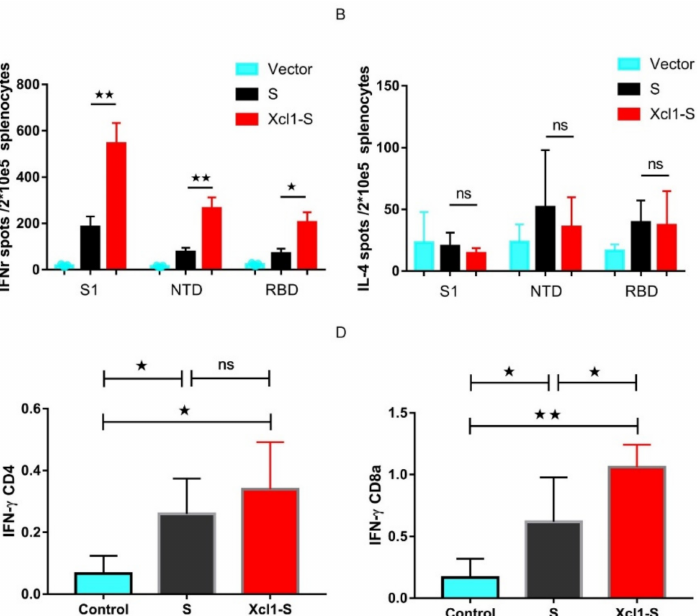
Figure 5. Xcl1-S vaccination elicited a significant increase in cellular immune responses. ( A , B ) The number of IFN- γ -expressing cells ( A ) and IL-4-expressing cells ( B ) from splenocytes were measured by ELISpot. Data are mean ± SEM of the spleens from n = 5 mice per group. ( C , D ) Splenocytes were stimulated with a combined mixture of S peptide pools for 18 h. The frequency of S-specific IFN- γ CD4 + and CD8 + T cells was determined using a flow cytometry analysis. Summary graphs showing the frequencies of IFN- γ CD4 + and CD8 + T cells after vaccination. Data shown in the graphs represent the average of five mice in each group, and error bars represent SEM. (cid:70) , p < 0.05, (cid:70)(cid:70) , p <